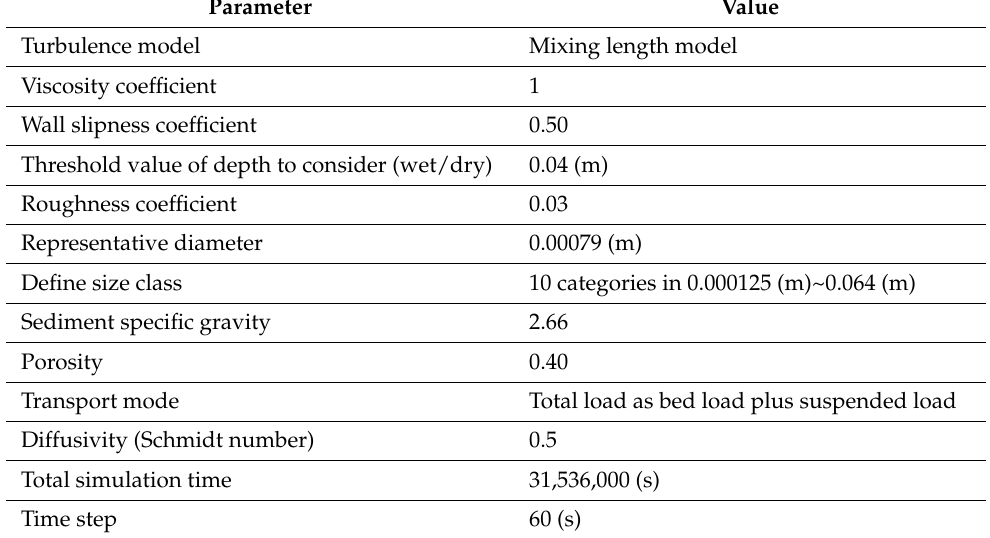
Table 4. Inputs of CCHE2D model in